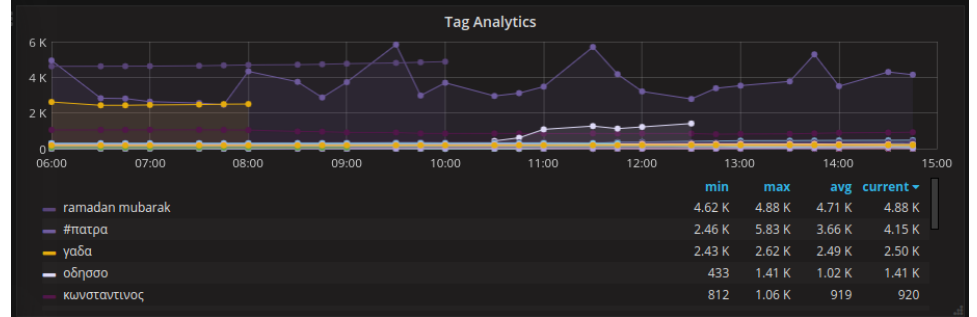
Figure 2. Sample Visualization of trending topics.